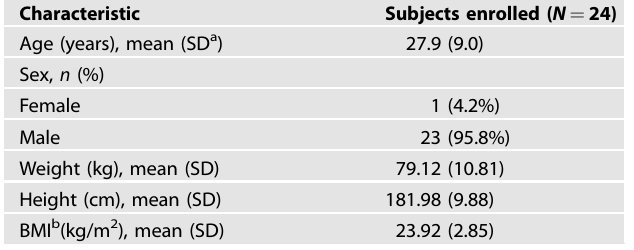
Table 2. Demographic characteristics of study participants. Characteristic